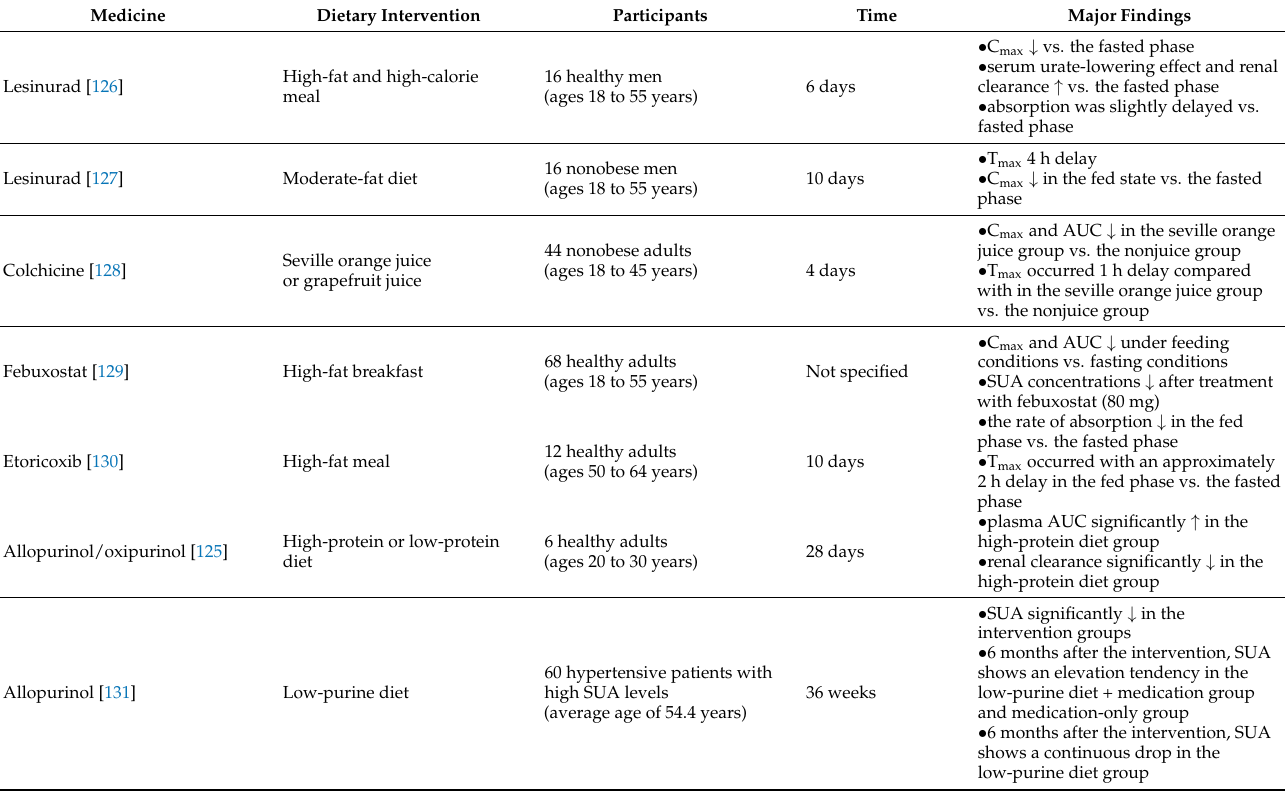
Table 2. Combination of nutrition modification and drug